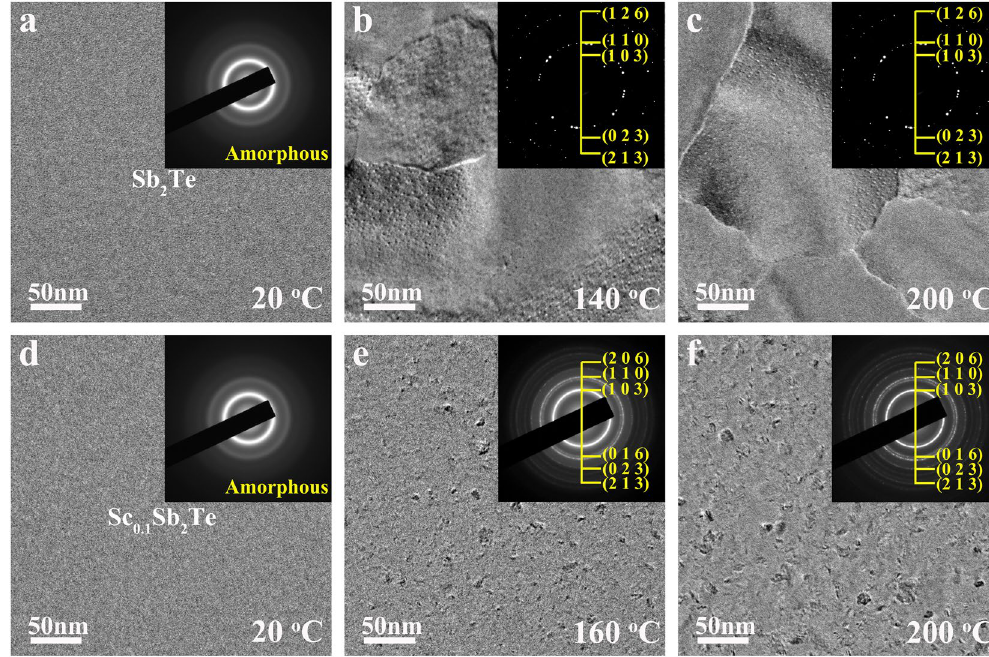
Figure 2. TEM BF images and their corresponding SAED patterns reveal the in-situ thermally-induced crystallization processes of ( a – c ) Sb 2 Te and ( d – e ) Sc 0.1 Sb 2 Te films at different temperature.